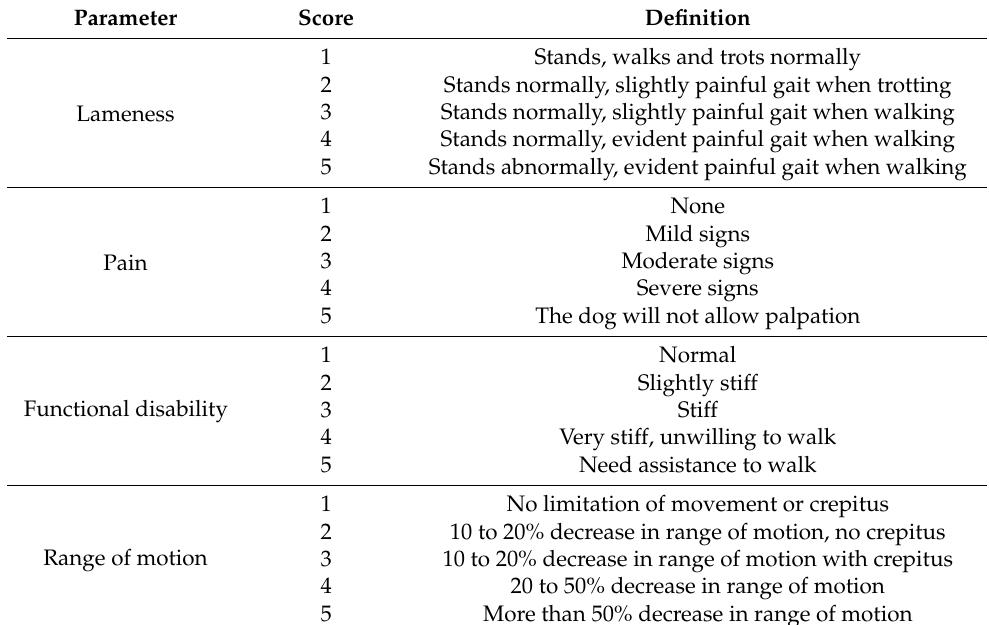
Table 2. Overview of the score systems used for the orthopaedic examination.